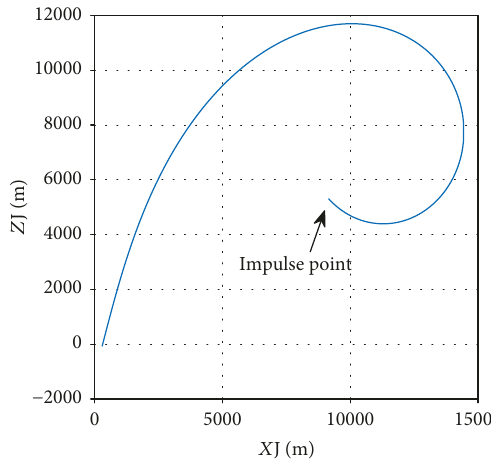
Figure 3: Under the high-precision model, the distance from the projectile to the target during the interception process in the o-xz plane.